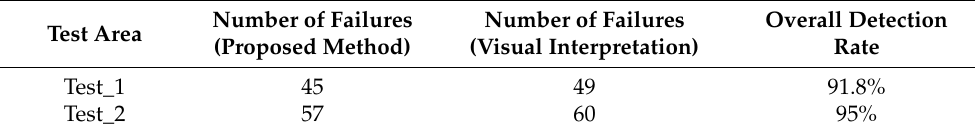
Table 4. Overall detection rates of Test_1 and